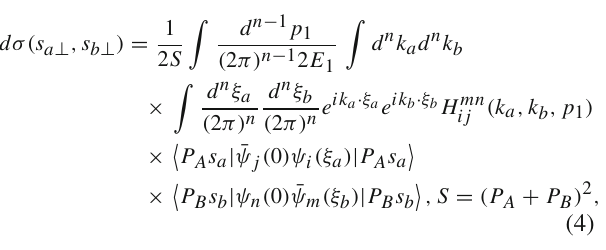
Fig. 1 Leading region for heavy quark production. The central bubble represents hard region, and upper and lower bubbles represent collinear